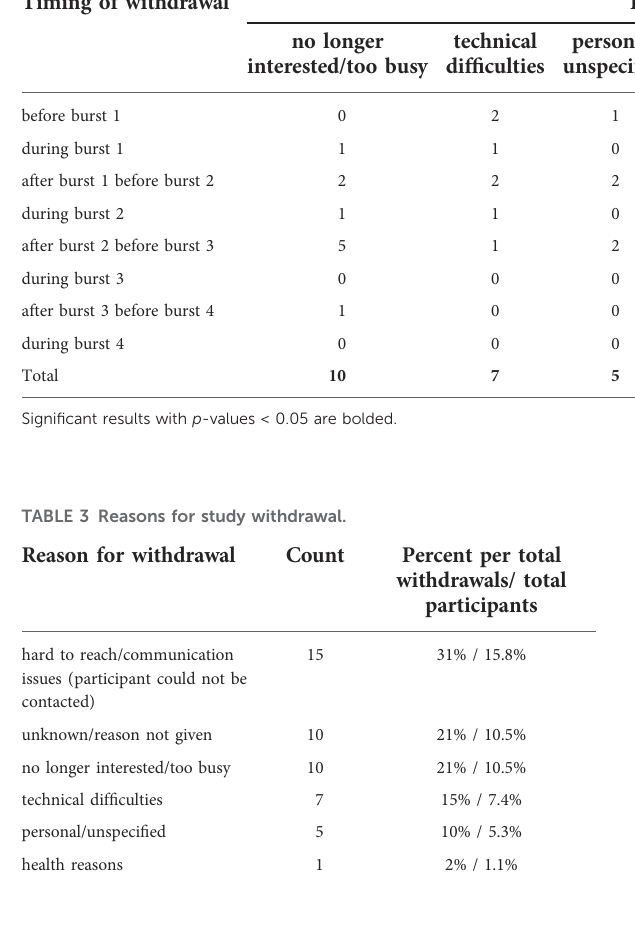
TABLE 2 Timing and reason for withdrawal.